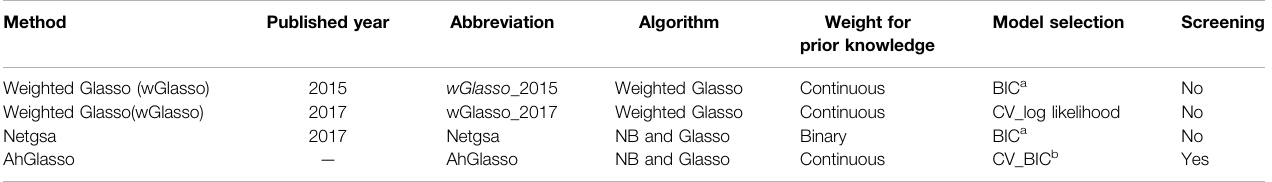
TABLE 1 | Summary of network learning methods to incorporate prior knowledge. Method